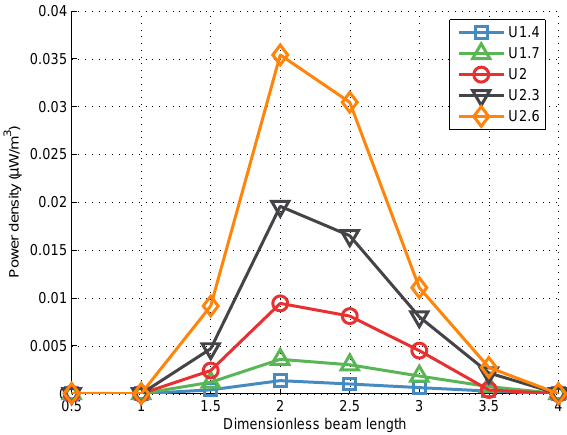
Figure 12. The averaged density of output power for different plate lengths under various